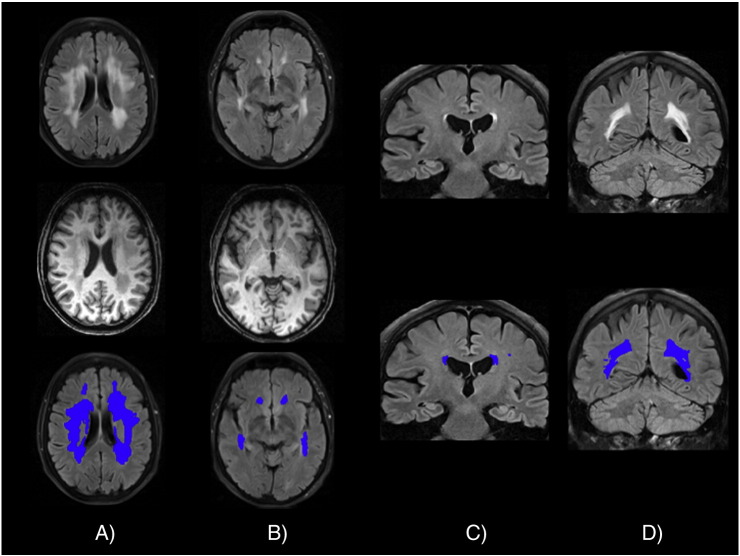
Examples of manual masks for different datasets (a,b Dataset 1; c,d Dataset 2) and WMH load (a,c low WMH load; b,d high WMH). Top row shows the FLAIR images, the bottom row shows the manual mask overlaid in blue. For Dataset 1, the corresponding T1w image is shown in the middle row.